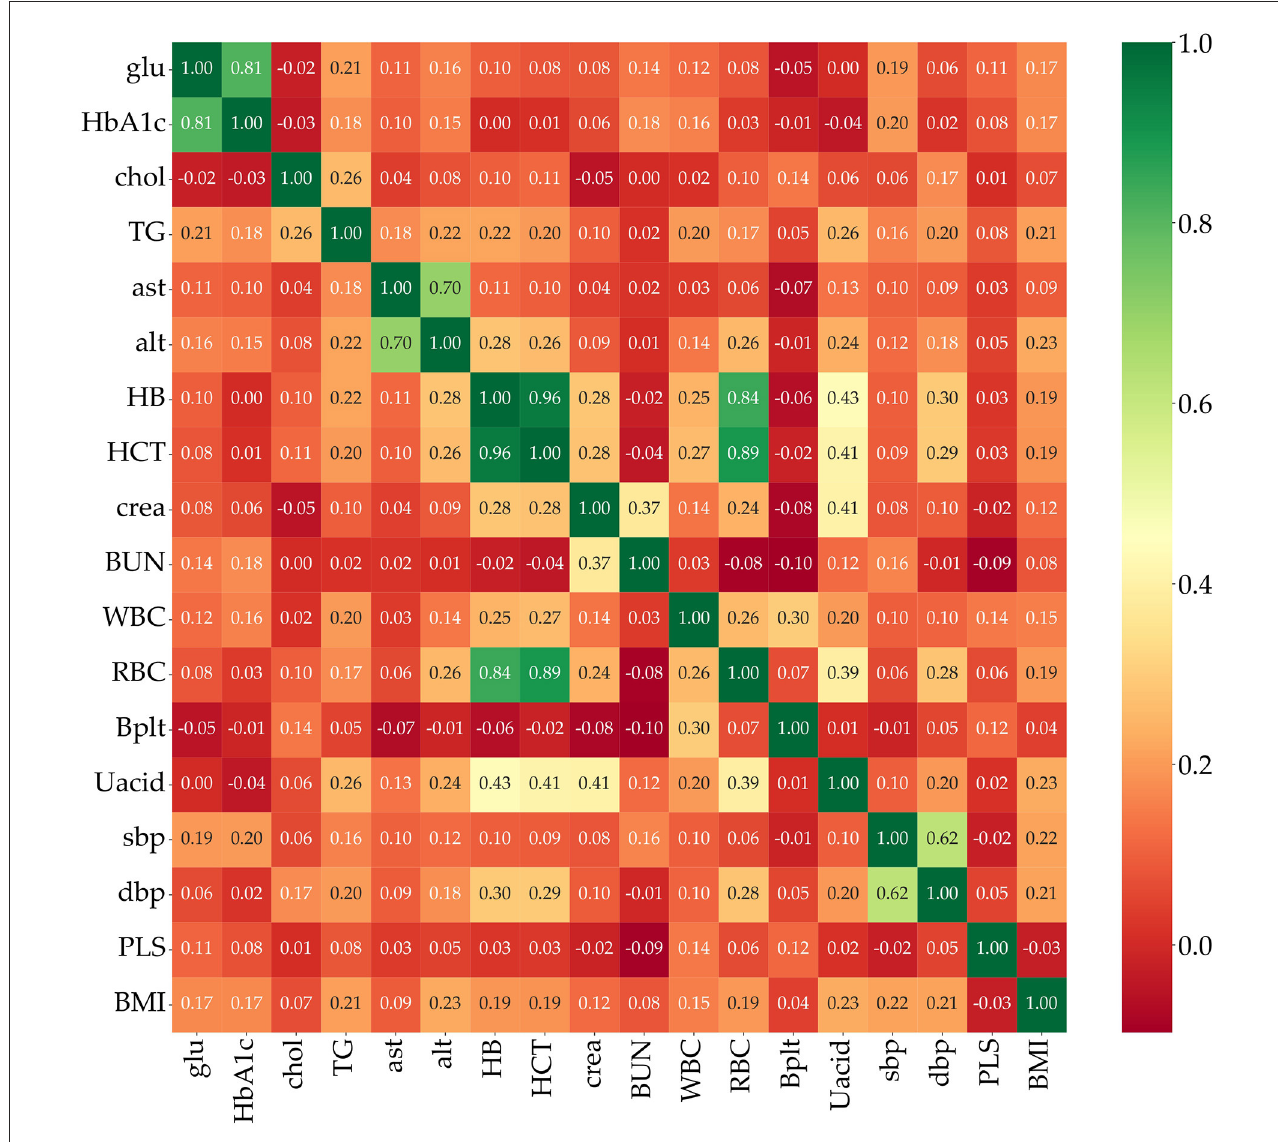
FIGURE3 Correlation between BMI and 17 selected metabolic features given in the KNHANES.